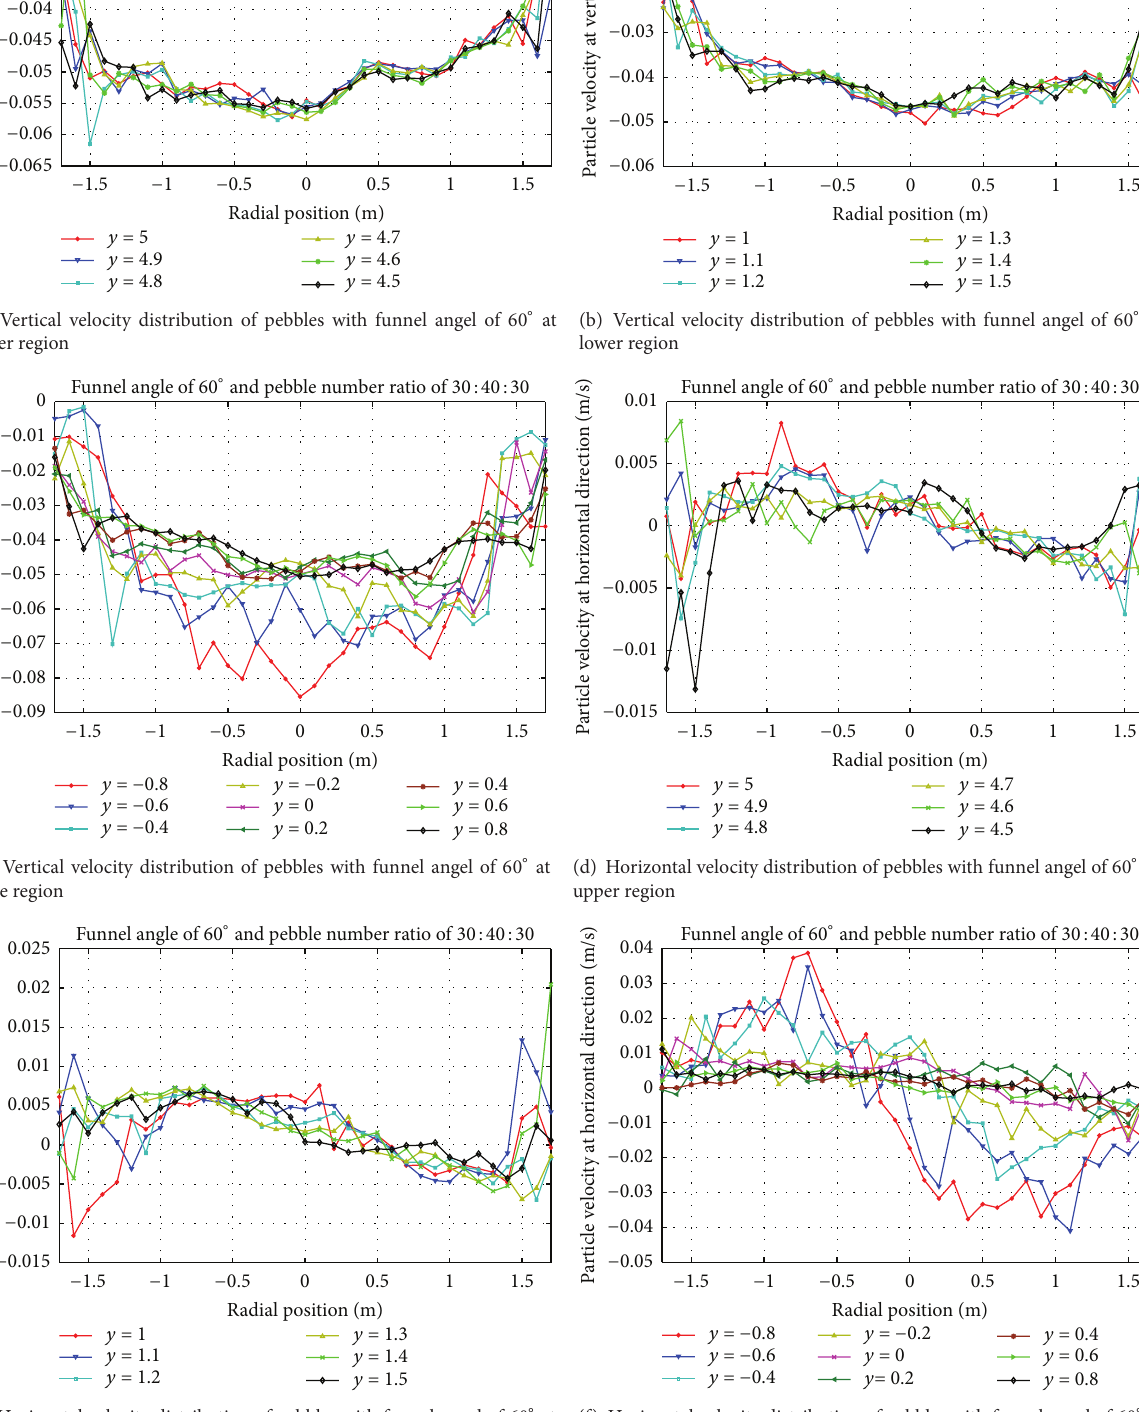
(e) Horizontal velocity distribution of pebbles with funnel angel of 60 ∘ at (f) Horizontal velocity distribution of pebbles with funnel angel of 60 ∘ at lower region cone region Figure 8: Pebble velocity distributions at different positions of the bed with funnel angle of 60 ∘